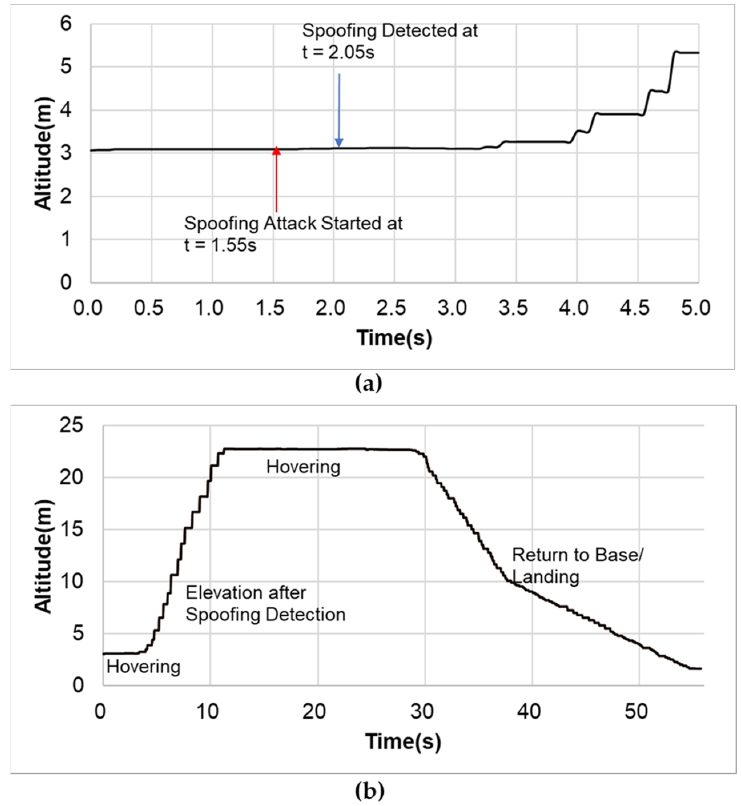
Figure 13. Flight trajectories; ( a ) from t = 0 to 5 s ( b ) during the flight test. Figure 14 represents the feedback loop of an anti ‐ spoofing enabled drone. The con ‐ troller aims to minimize the error between the desired states and estimated states, includ ‐ ing position, velocity, or attitude of the drone [31]. Monitoring the GPS states using 1D CNN classifier, we determine whether the current signal is authentic or spoofed in real ‐ time. Once spoofing is detected, we cancel all the operations. Then, the return to base (R2B) command will be proceeded by moving to a higher altitude.